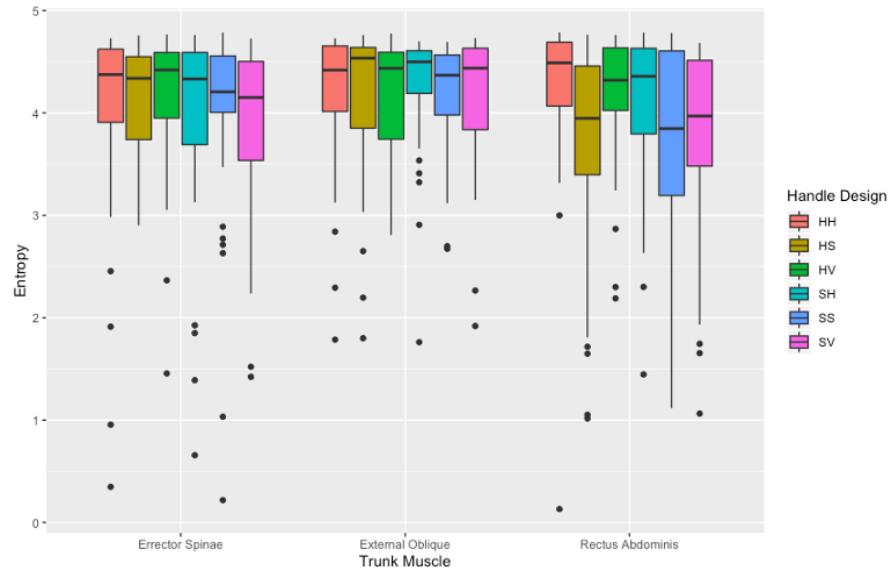
Figure 9. Entropy (a.u) (mean ± SD) values of the three trunk muscles between handle designs at the initiation of the push. Outliers are noted as black dots.